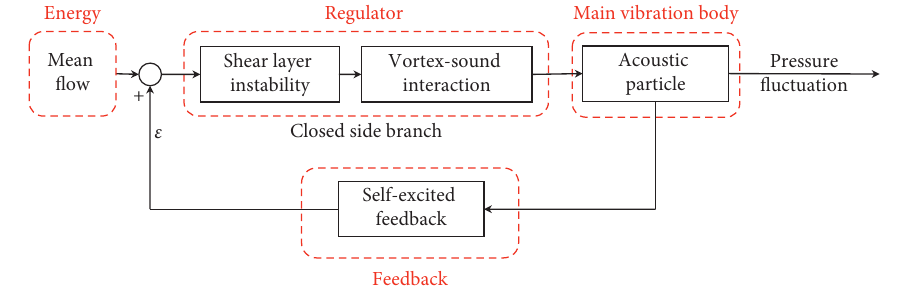
Figure 1: Schematic diagram of feedback